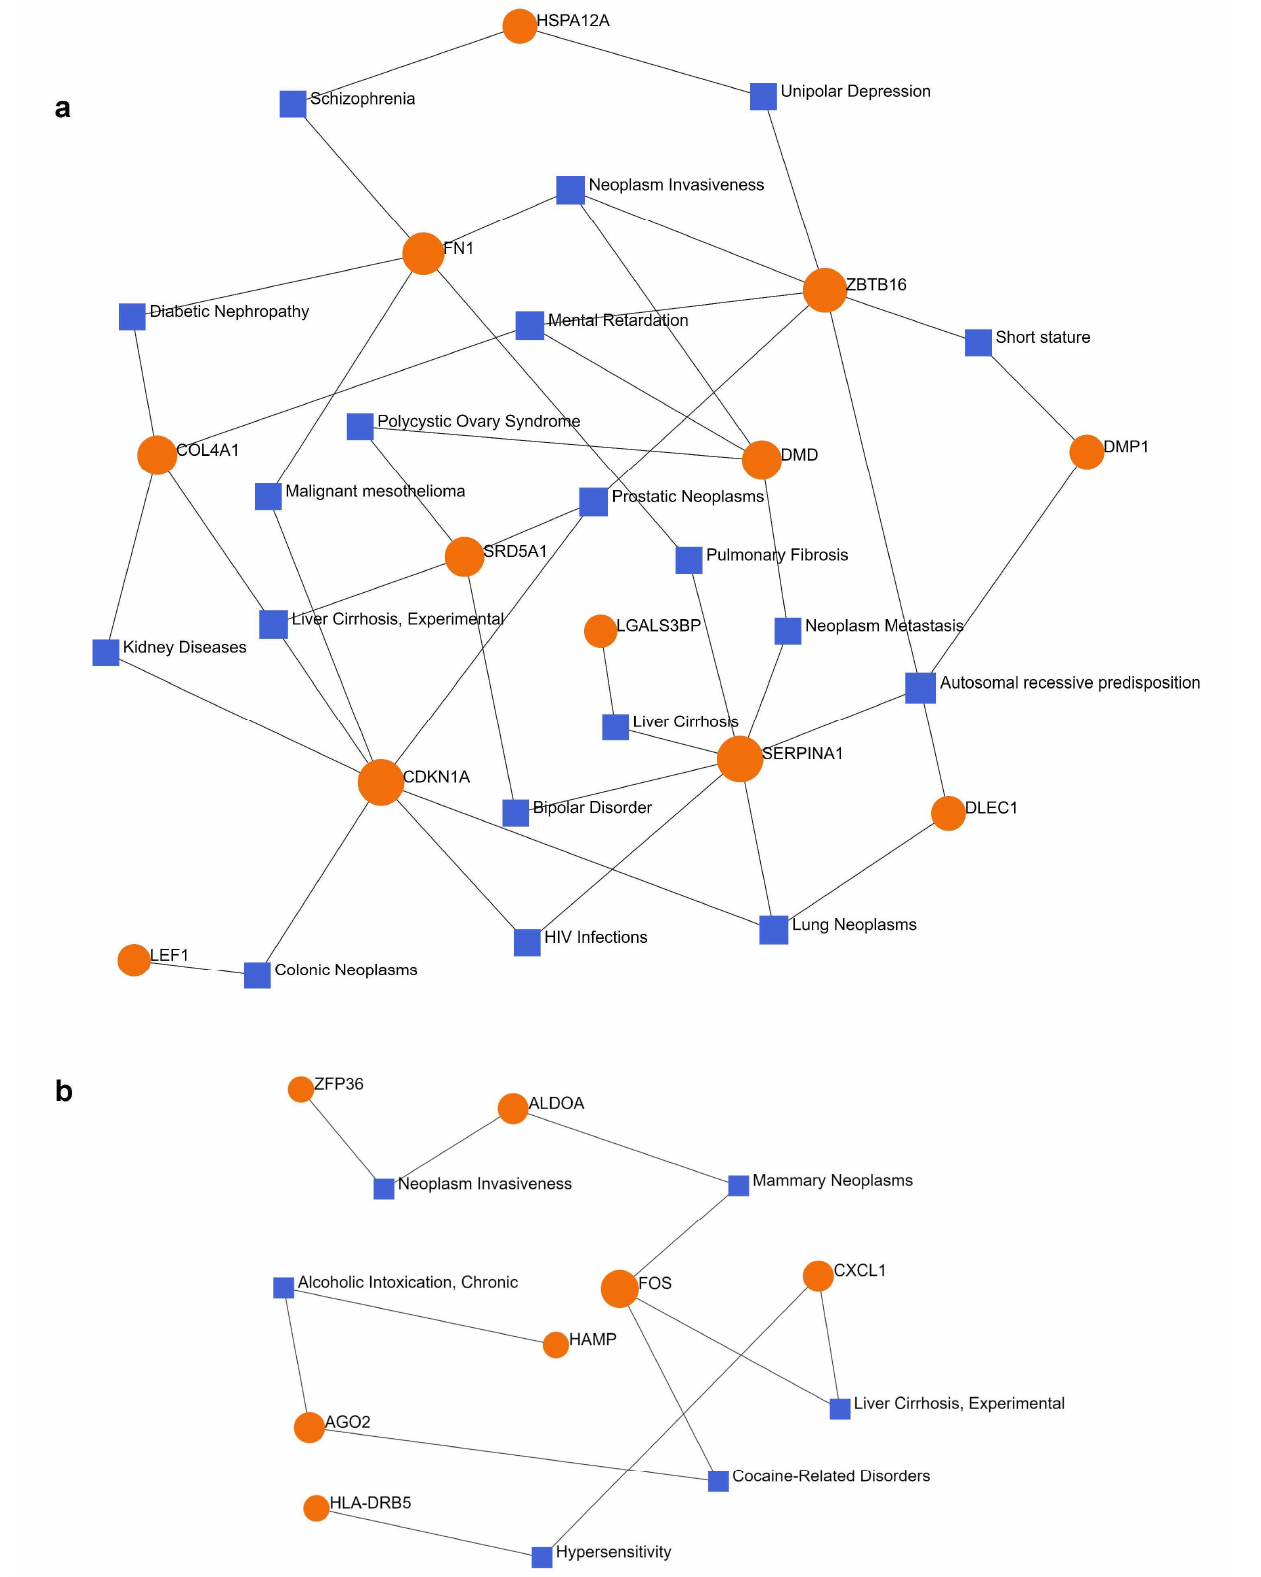
Figure 4. Disease–gene network analysis. ( a ) Disease–gene network analysis of switch genes from subjects with chronic loneliness and ( b ) diseases associated with switch genes from males with chronic loneliness. Switch genes are depicted in orange and diseases are in blue.